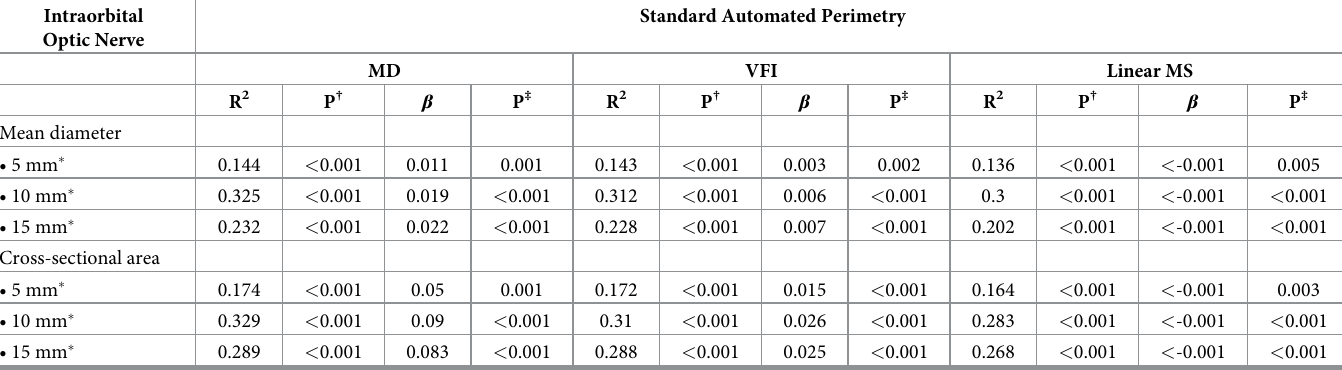
Table 6. Structure-function relationship between 3-Tesla magnetic resonance imaging findings of the intraorbital optic nerve and standard automated perimetry outcomes. Intraorbital Optic